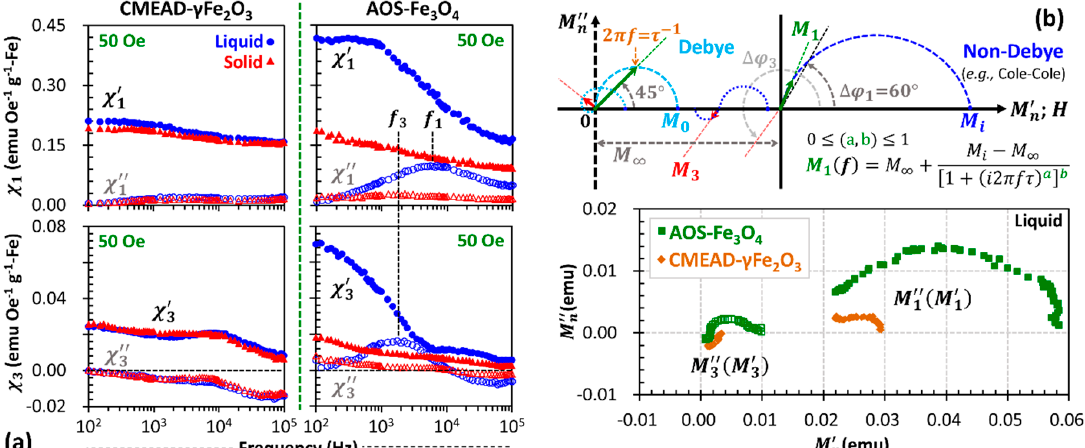
Figure 3. ( a ) Frequency-dependent complex magnetic susceptibilities at 50 Oe. The field-induced cluster rotation is recognized from the spectral shift of the imaginary peaks between the imaginary (cid:2031) (cid:2869)(cid:4593)(cid:4593) and (cid:2031) (cid:2871)(cid:4593)(cid:4593) parts (open circles), in addition the larger real (cid:2031) (cid:2869)(cid:4593) ’ and (cid:2031) (cid:2871)(cid:4593) ’ parts (solid circles) than those of the solidified samples (solid triangles). The imaginary parts for the solid samples (open triangles) are later attributed to the moment dynamics; ( b ) Illustrative (cid:1839) (cid:3041)(cid:4593)(cid:4593) (cid:4666)(cid:1839) (cid:3041)(cid:4593) (cid:4667) plot of an empirical relaxation model with (cid:1853) and (cid:1854) fitting parameters [16]. The semicircle Cole-Cole model can be partially fitted to the (cid:1839) (cid:2869) (cid:4593)(cid:4593) (cid:4666)(cid:1839) (cid:2869) (cid:4593) (cid:4667) plots of the ferrofluid samples, whereas (cid:1839) (cid:2871) (cid:4593)(cid:4593) (cid:4666)(cid:1839) (cid:2871) (cid:4593) (cid:4667) appears to have unique patterns.